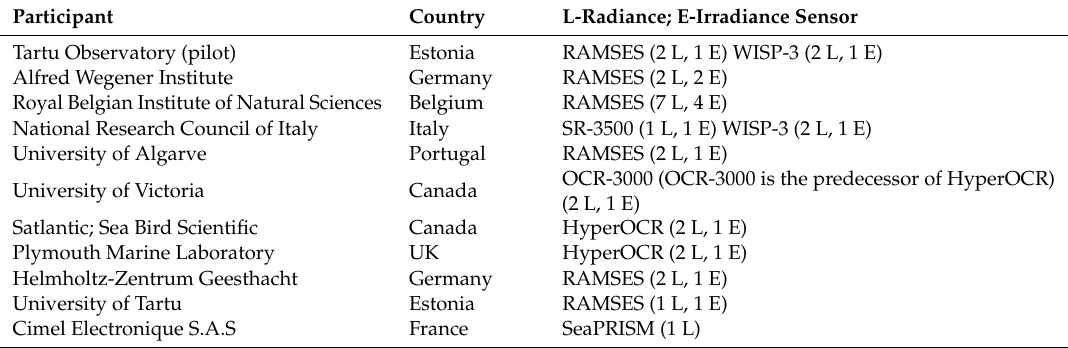
Table 1. Institutes and instruments participating in the LCE-2 intercomparison.